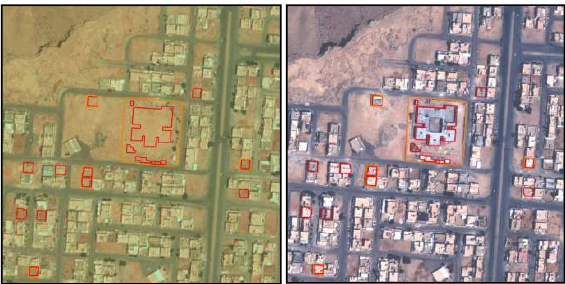
Figure 11. Updated map overlaid with aerial orthophoto of 2007 (left) and GeoEye-1 orthophoto from 2010 used for mapping